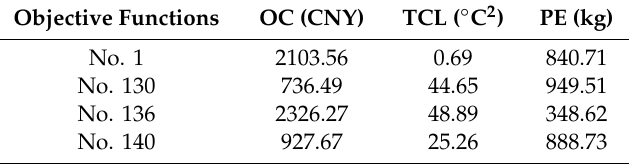
Figure 8. The optimal scheduling results for RR-microgrid with RFHCS. ( a ) A typical day in winter; and ( b ) a typical day in summer. Table 11. Value of objective functions of different scheduling schemes for the typical day in winter.